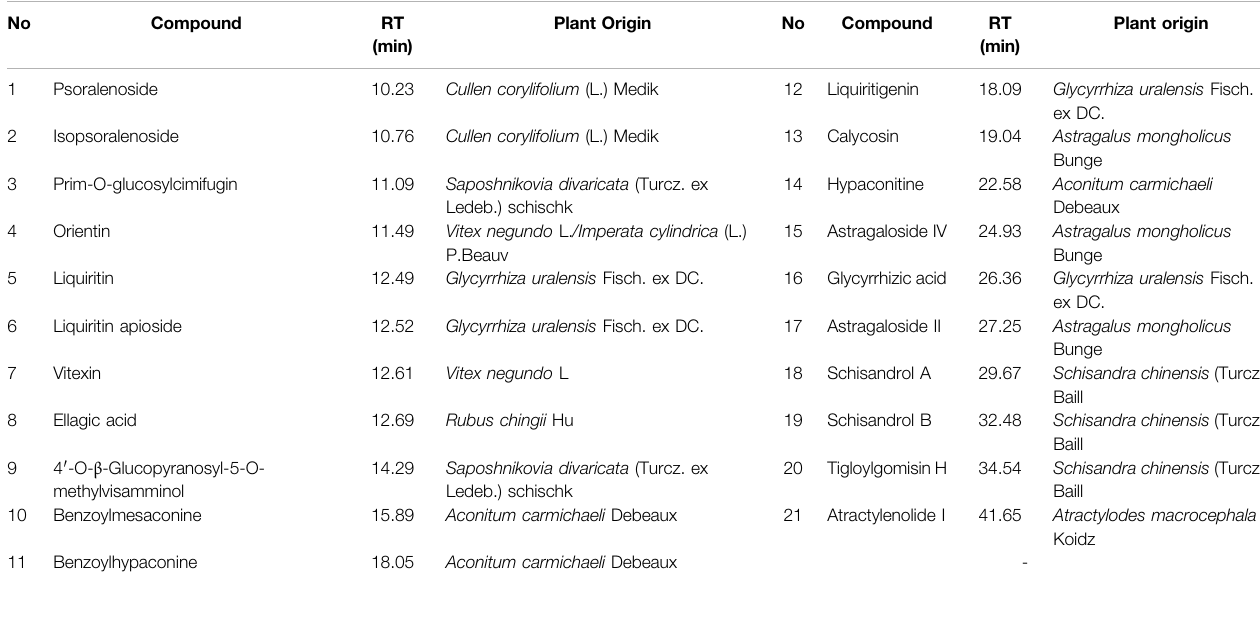
TABLE 3 | Identi fi cation of 21 components of JWYPFS by standards and